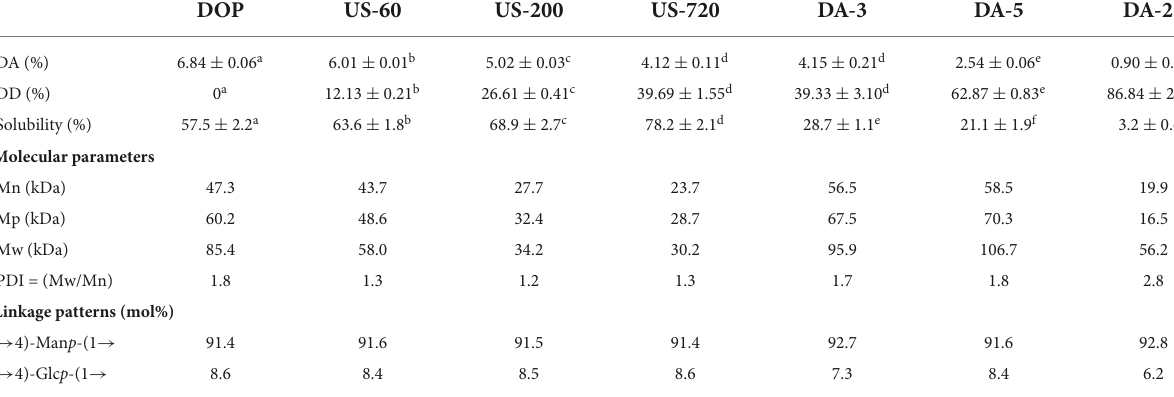
TABLE 1 The structural characterization of native and modified DOPs.